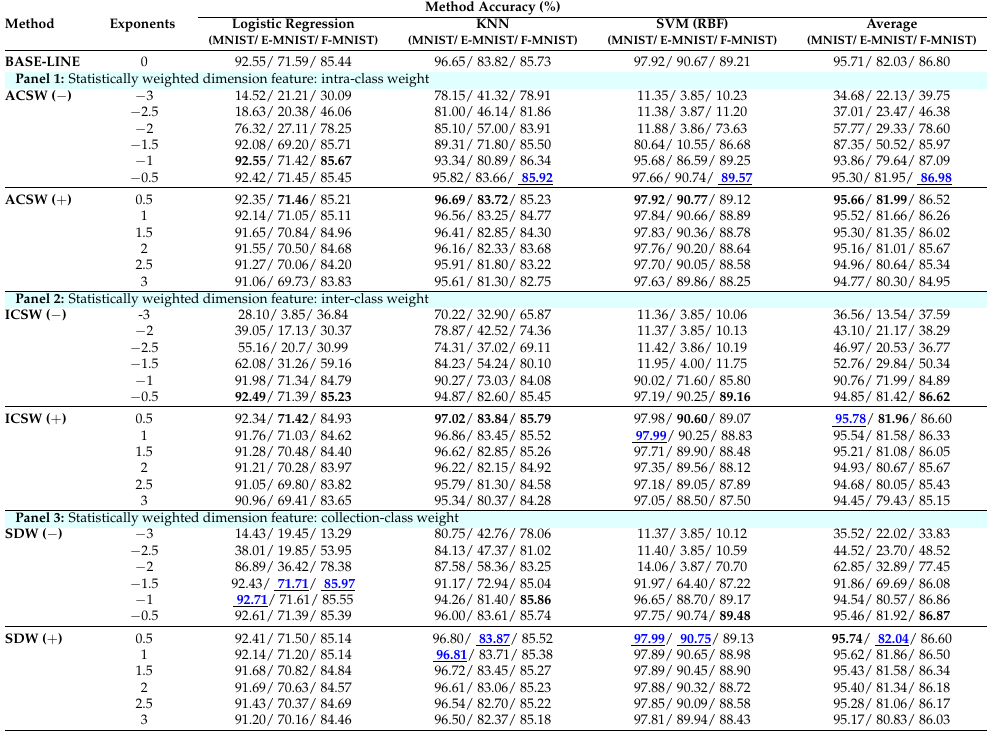
Table 2. Feature-weighting comparison on demoted and promoted sides.